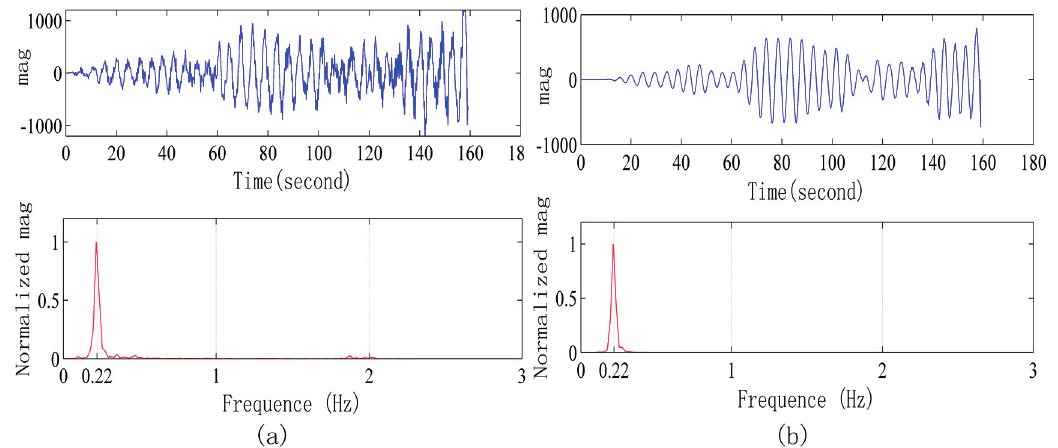
Figure 10. ( a ) Signal waveform of Figure 9a after removing the baseline, self-correlation processing and its power spectrum. ( b ) Signal waveform of Figure 10a after ALE processing and its power spectrum.